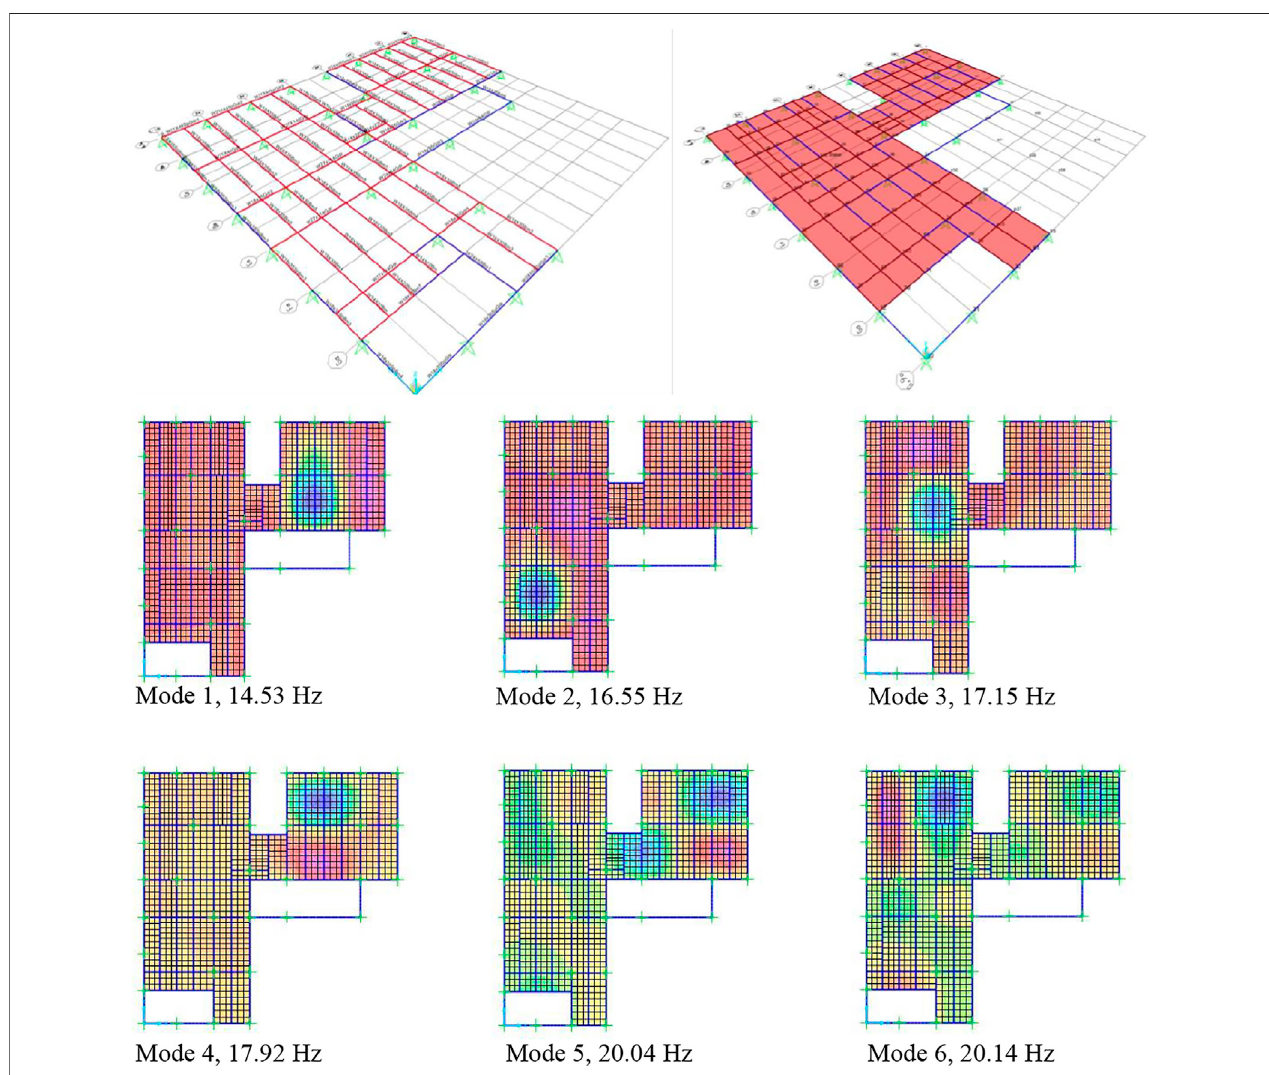
FIGURE 7 | The FE model and the predicted mode shapes (bare slab con fi